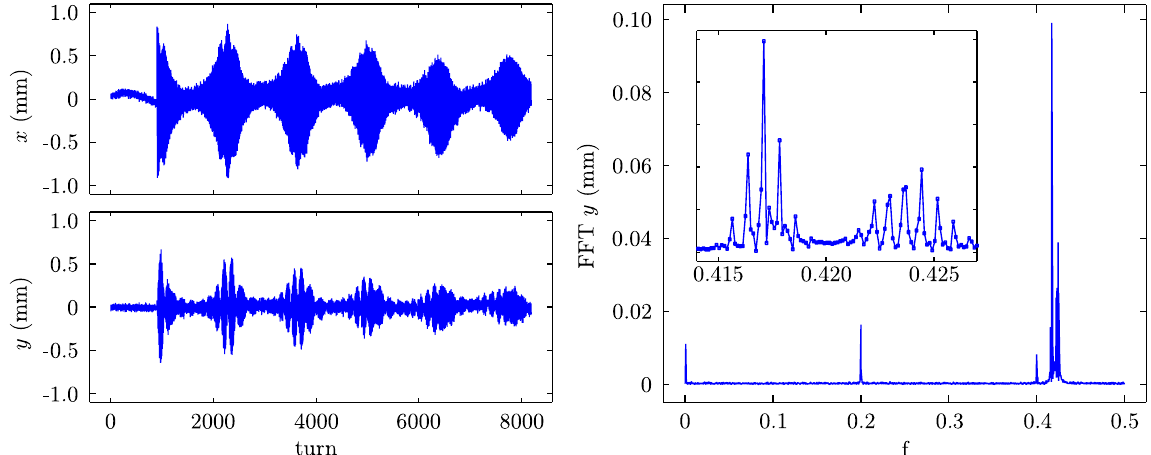
FIG. 2. Coherent transverse oscillations of proton beam in the Tevatron recorded by horizontal and vertical BPMs (left). At about 900th turn beam was kicked in the horizontal plane. FFT amplitude of the vertical BPM signal is shown on the right. Timing errors of BPM electronics with the periodicity of five turns produce coherent lines at tunes of 0.2 and 0.4. Oscillation amplitude damping is due to nonlinear decoherence of betatron oscillations. Proton beam parameters in the Tevatron: momentum spread (rms), 1 : 2 (cid:2) 10 (cid:1) 4 (at 980 GeV); normalized emittance (95%), 18 (cid:5) mm mrad .